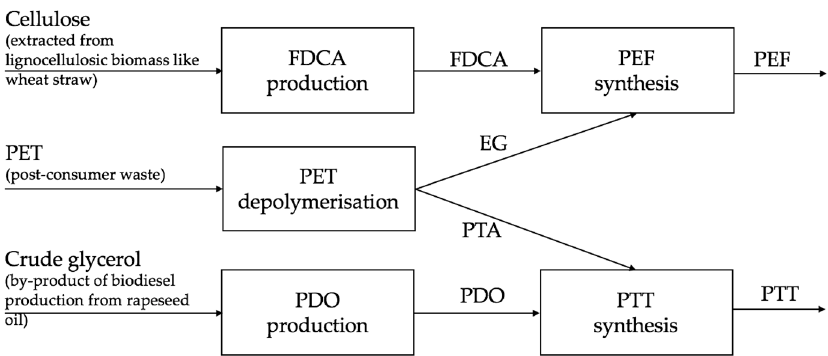
Figure 1. Block flow diagram showing the concept and material flow of the PET plastic biorefinery: three waste streams (biodiesel-derived crude glycerol, post-consumer PET and lignocellulosic biomass-derived cellulose) can be used to synthesise PEF and PTT.